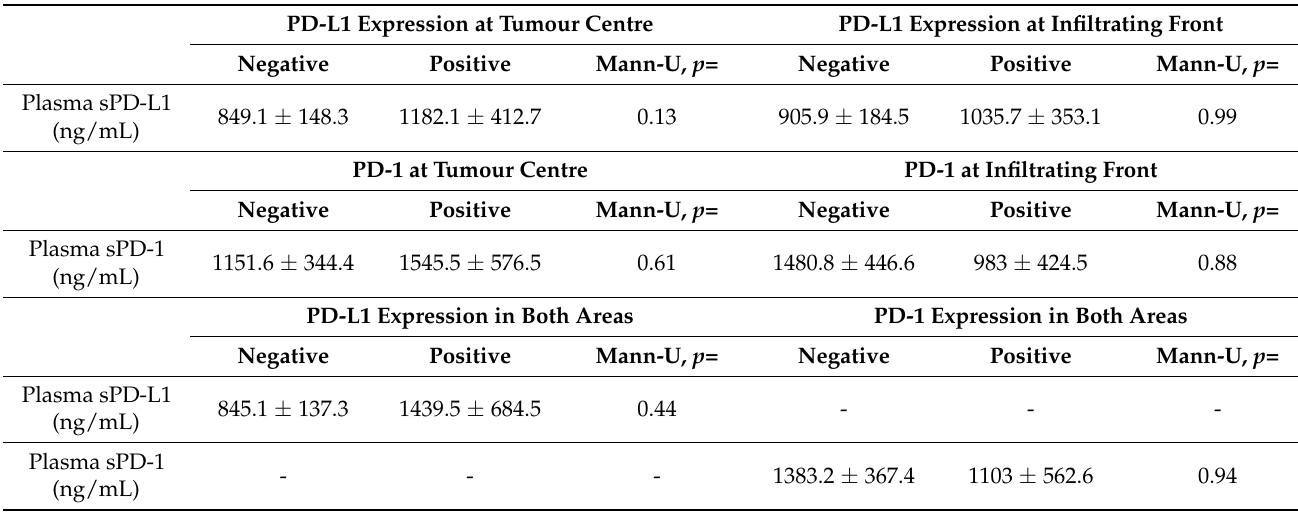
Table 2. Plasma sPD-L1 and sPD-1 levels in CCRCC patients in terms of PD-L1 and PD-1 expression in CCRCC